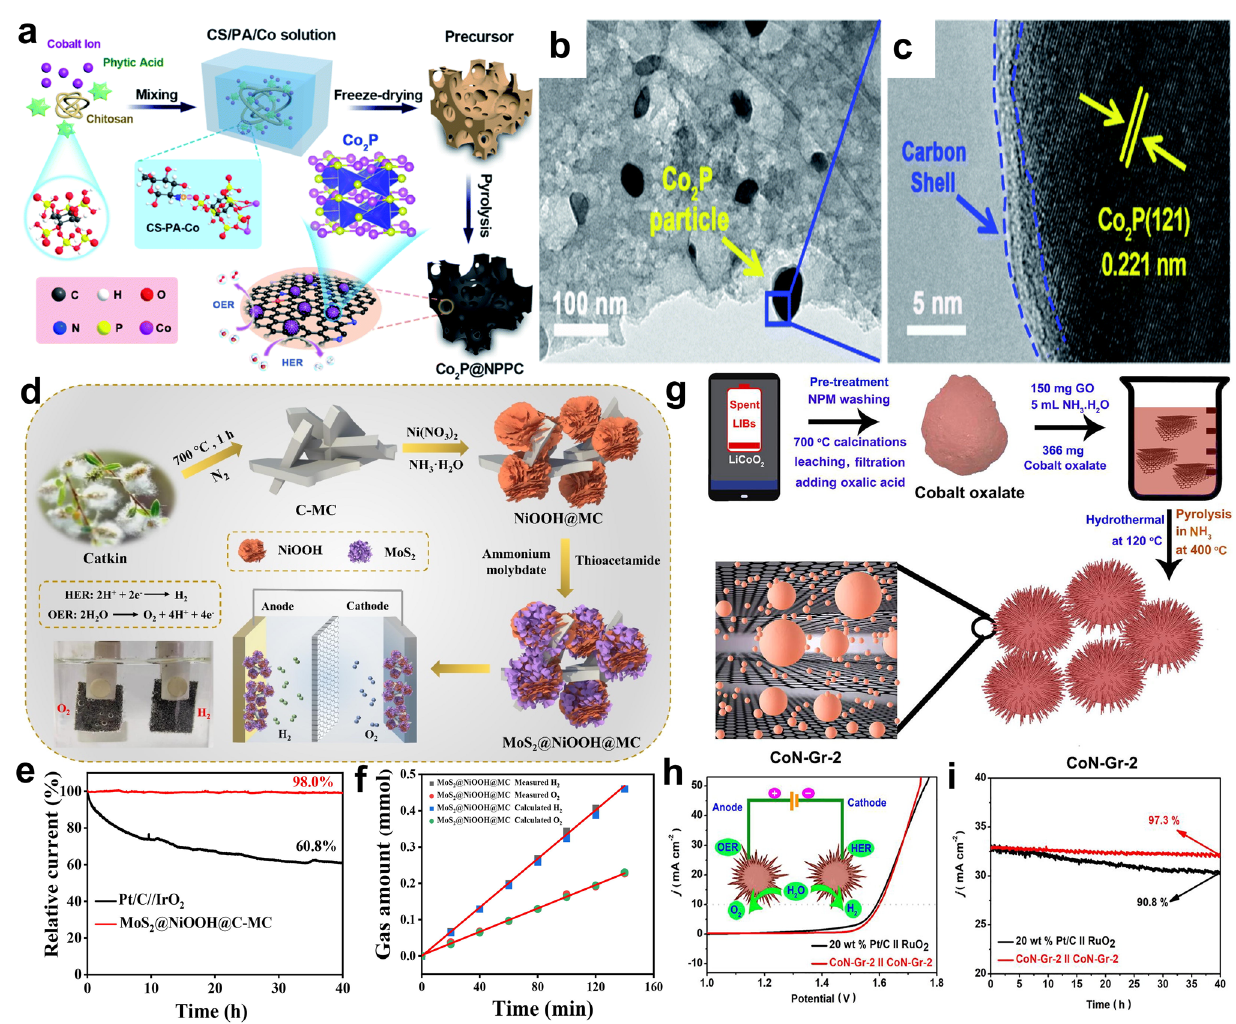
Fig. 14 a Diagram of the preparation of Co 2 P@NPPC. b TEM and c high resolution TEM (HRTEM) images of Co 2 P@NPPC [190]. Copyright 2021, Royal Society of Chemistry. d Scheme of the synthesis of the MoS 2 @NiOOH@C‑MC composite. e Stability test of the Pt/C||IrO 2 and MoS 2 @NiOOH@C‑MC||MoS 2 @NiOOH@C‑MC couples for OWE, at 10 mA cm −2 . f The time‑dependent of the experimental and theoretical